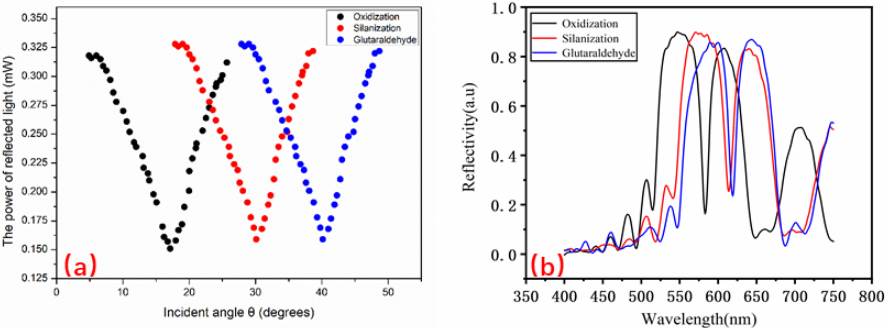
Figure 4. ( a ) Angle spectrum contrast for the PSM functionalization; ( b ) Comparison of the reflection spectra of functionalized PSM.